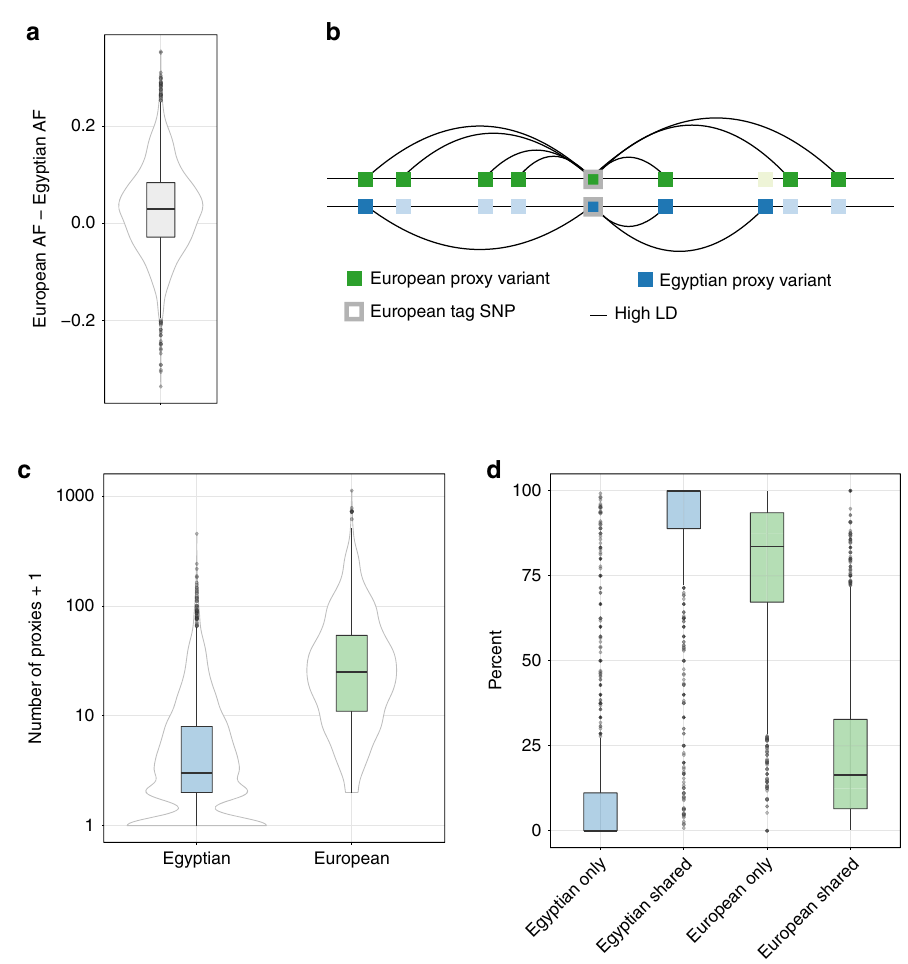
Fig. 3 Comparison of Egyptian (blue) and European (green) allele frequencies (AF) and proxy variants for n = 3,698 GWAS tag SNPs called in a minimum of 100 Egyptians. The box/violin plots display median and lower/upper quartiles; whiskers denote the most extreme data point no more than 1.5 times the interquartile range; outliers are data points extending beyond whiskers. The thin gray lines depict the respective distribution functions. a Box plot of AF differences. b Illustration of proxy variant counting shown in ( c ) and of proxy variant comparison shown in ( d ). A European GWAS tag SNP (center) and variants in Europeans (top) and Egyptians (bottom). Lines denote variants in high LD. The tag SNP has 7 proxy variants in Europeans and 3 in Egyptians. Light green/blue variants are no proxy variants in Europeans/Egyptians. Two proxy variants are shared. Thus 2 of 7 European (~29%) and 2 of 3 Egyptian (~67%) variants are shared. Further 5 of 7 European proxies are European-only (~71%) and 1/3 Egyptian proxies are Egyptian-only (~33%). c Box/ violin plots depicting the number of proxies. d Box plots showing the percentage of shared and Egyptian/European-only proxy variants using the same n = 3,698 GWAS tag SNPs as in ( a ) and ( c ). European shared: Percentage of European proxy variants shared with Egyptian proxy SNPs. European only: Percentage of European proxy variants not shared with Egyptian proxies. Egyptian shared/Egyptian only